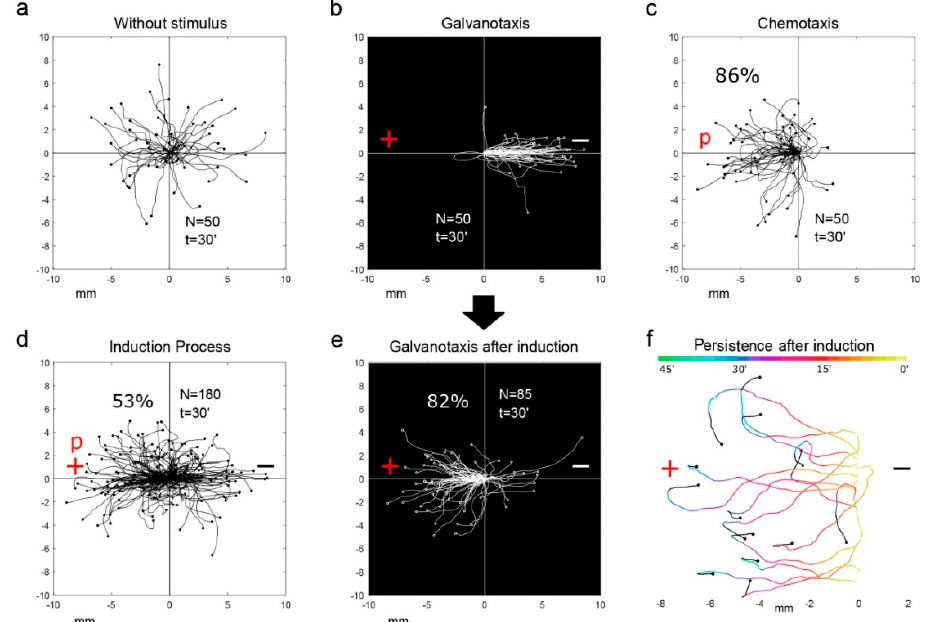
Figure 2. Experimental evidences of conditioned behavior in Amoeba proteus . (Part of this figure has been reported previously by the authors in ref. [83].) ( a ) Without stimulus, the cells practically explored all the directions of the experimentation chamber. ( b ) Under galvanotaxis, practically all the amoebae migrated towards the cathode. ( c ) Under chemotaxis, 86% of the cells migrated towards the chemotactic gradient. ( d ) Under galvanotaxis and chemotaxis simultaneously, 53% of the amoebae moved towards the anode-peptide (induced cells). ( e ) After induction process, the cells were placed in Chalkley’s medium without any stimulus for 5 min and then they were exposed to galvanotaxis for 30 min, 82% of the inducted cells presented lasting directionality towards the anode where the chemotactic peptide was absent. ( f ) Migratory trajectories of 15 amoebae under galvanotaxis, that previously acquired the conditioned behavior after induction process, lost gradually the persistence towards the anode and turned back to the cathode (times ranging from 27 to 44 min). The colors of the trajectories represent the duration of the conditioned behavior. “ N ” total number of cells, “ t ” time of galvanotaxis or chemotaxis. “ p ” chemotactic peptide (nFMLP), “ + ” anode, “-” cathode. In ( a )–( e ), both the x and y axis show the distance in mm and the initial location of each cell has been placed at the center of the diagram.